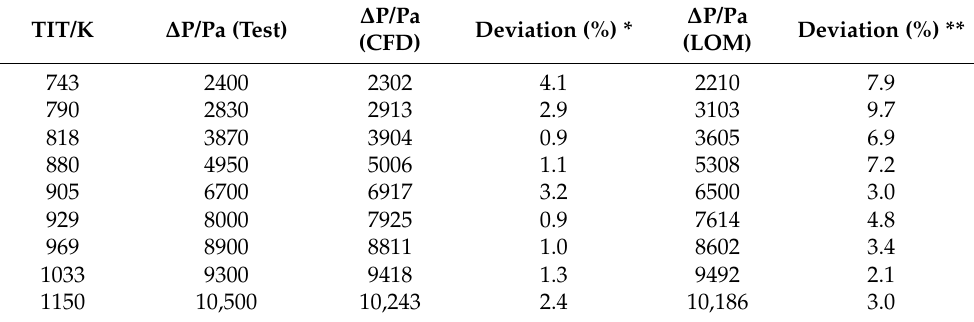
Table 6. ∆ P comparisons against test measurement at various TIT conditions.